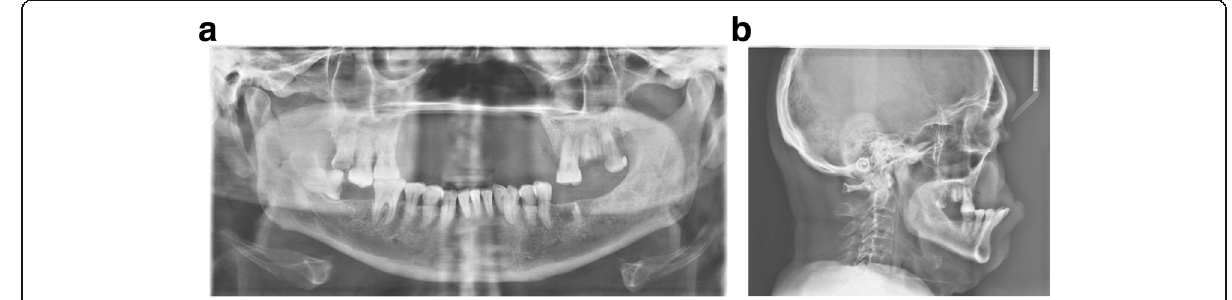
Fig. 3 a Pre-operative OPG. All the upper incisors up to premolars missing bilaterally, as well as lower left molars. b Pre-operative laterocephalogram